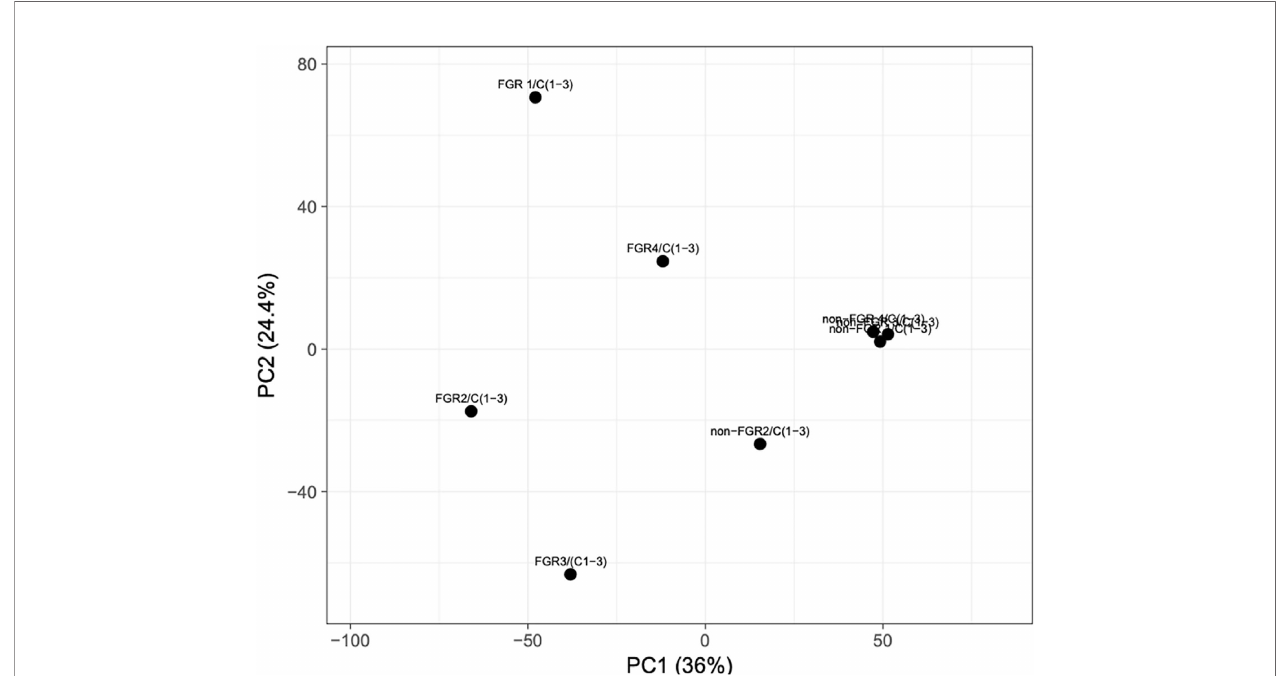
FIGURE 2 | Principal component analysis (PCA) of all quanti fi ed proteins revealed that liver of fetal growth restricted pups had a heterogeneous proteomic pro fi le compared to non-FGR ones.